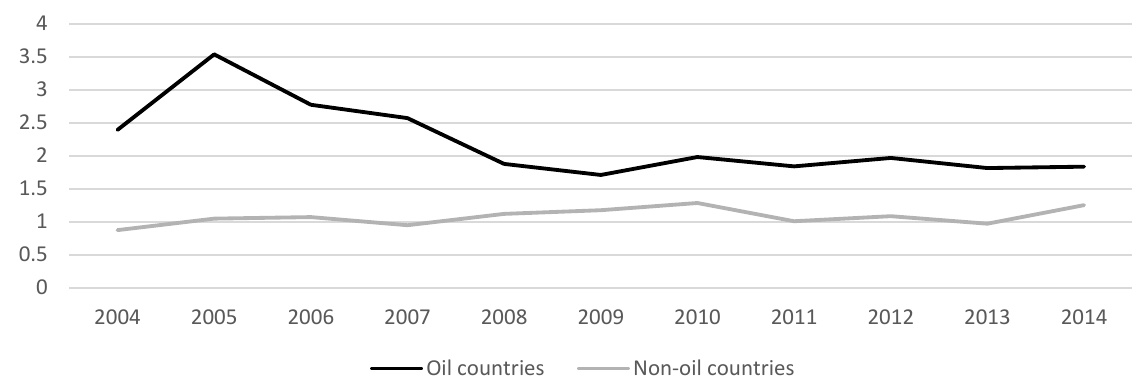
Figure 1. The profitability of oil and non-oil countries of MENA region over the period 2004–2014